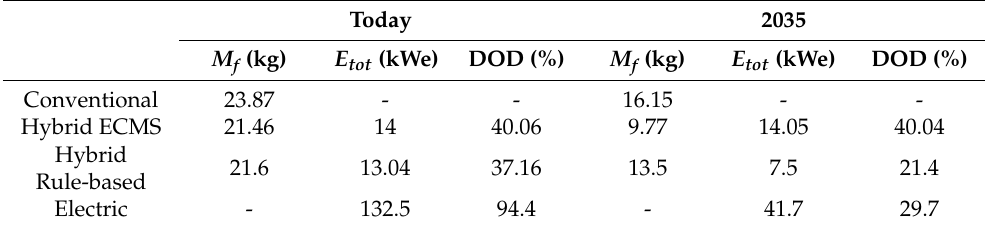
Table 6. Burn fuel, electricity consumption, and battery DOD for the air taxi.